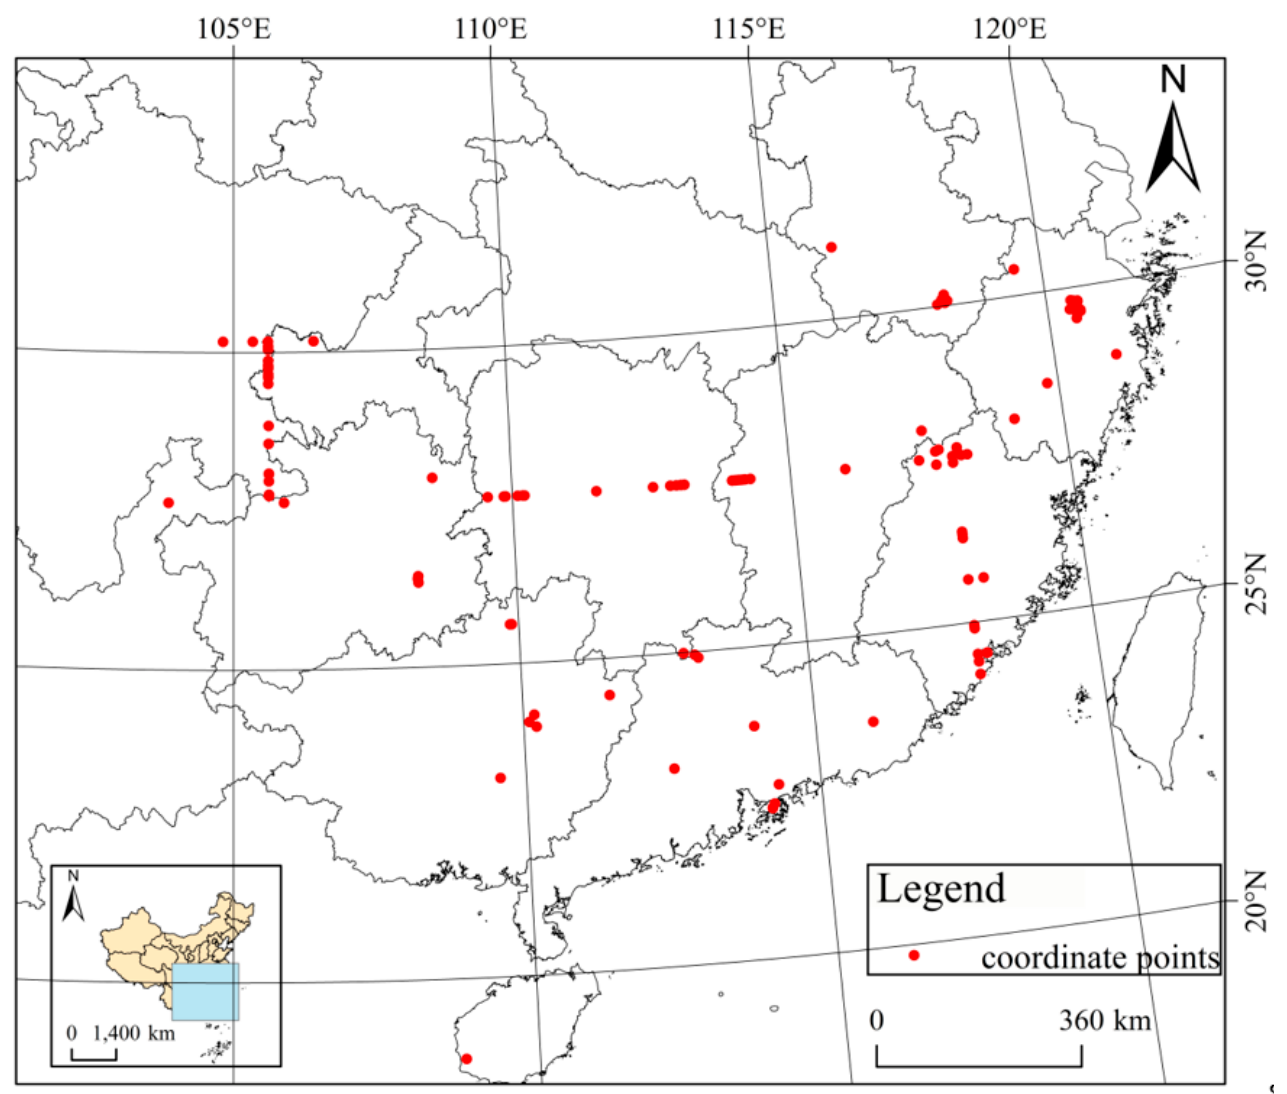
Figure 1. Confirmed coordinate distribution of Quasipaa spinosa in China.